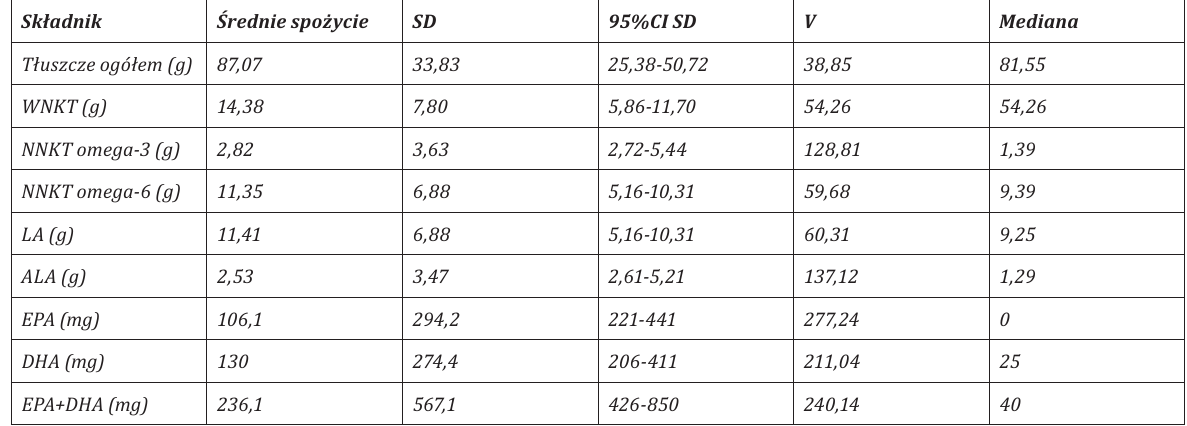
Tabela 7. Spożycie tłuszczu w badanej populacji -